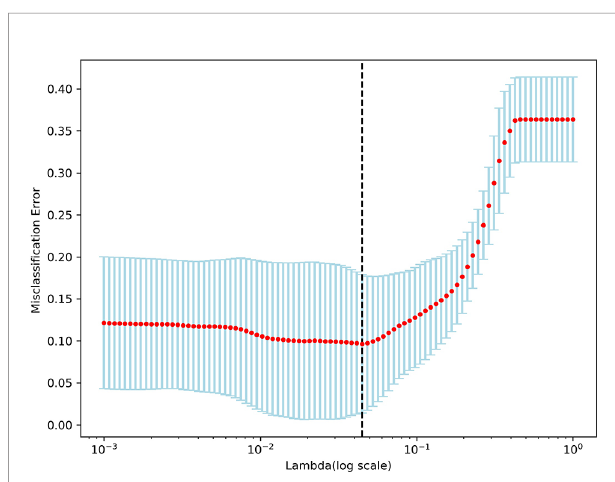
FIGURE 2 | Tuning parameter ( l ) selection in the LASSO